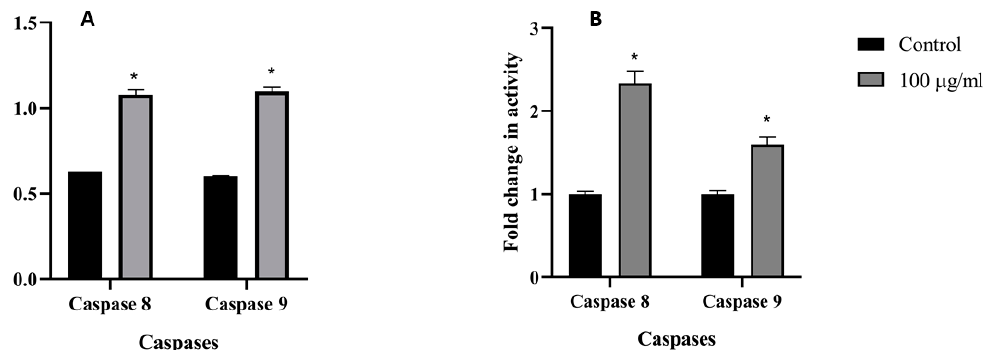
Figure 3. Caspases 8 and 9 activity on the MCF-7 ( A ) and the HCT-116 ( B ) cell lines, the control groups were without any treatment, and the M. fruticosa extract groups were treated with 100 μ g/mL for 48 h, * p < 0.01.